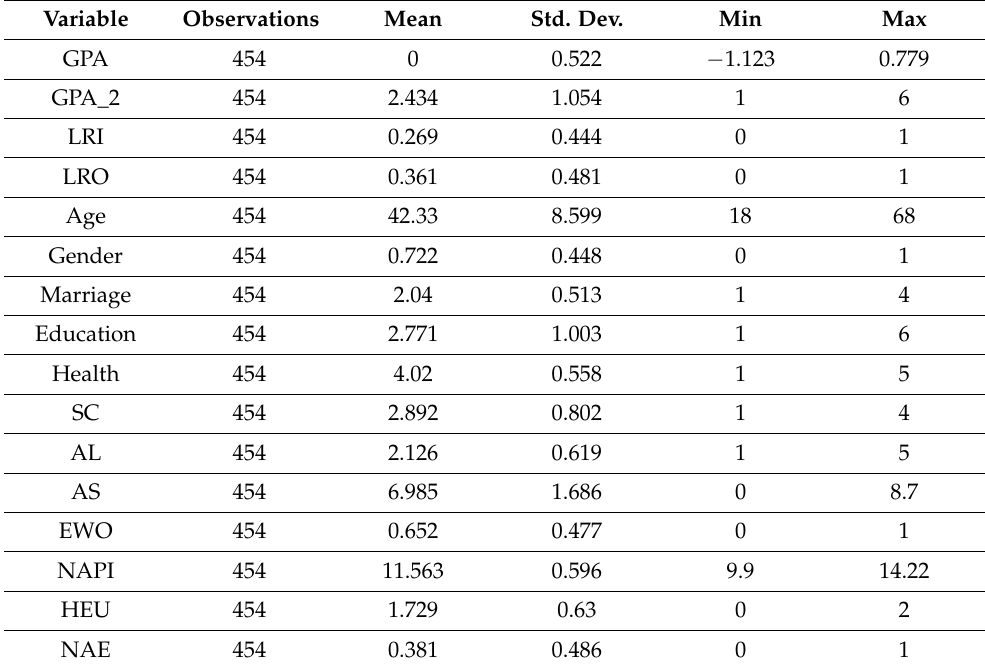
Table 2. Results of descriptive statistics for